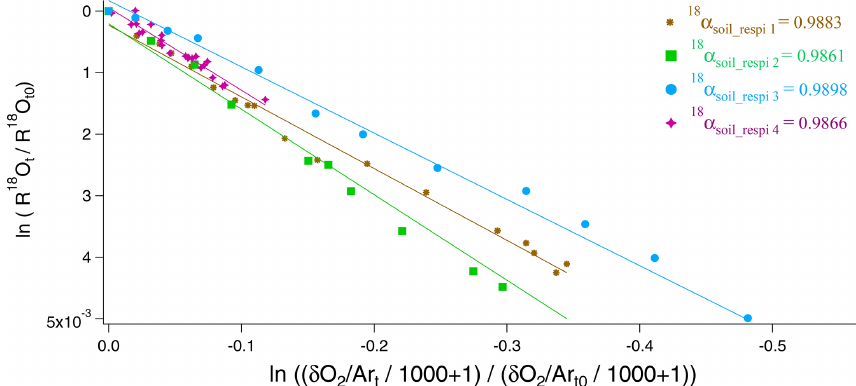
Figure 3. Determination of 18 O / 16 O fractionation factors in the four respiration sequences. 18 α soil_respi1 (brown), 18 α soil_respi2 (green), 18 α 18 α soil_respi3 (blue), and soil_respi4 (purple) are, respectively, respiratory fractionation factors associated with sequences 1 to 4.